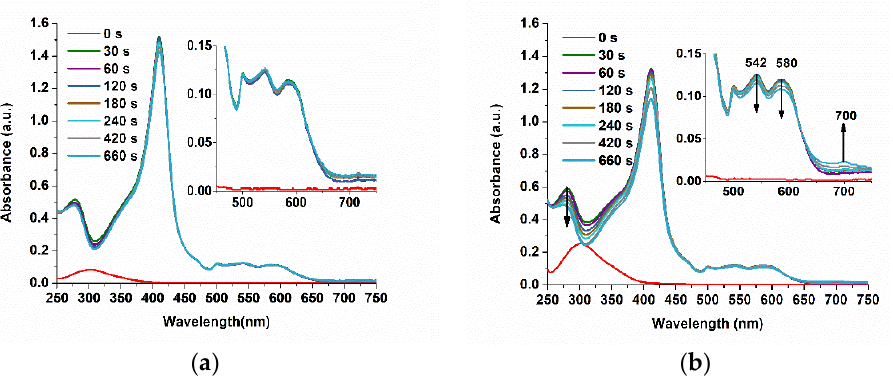
Figure 12. UV-Vis spectra of ( a ) 50 µM PON and ( b ) 150 µM PON incubated with 15 µM metMb, at different incubation periods.